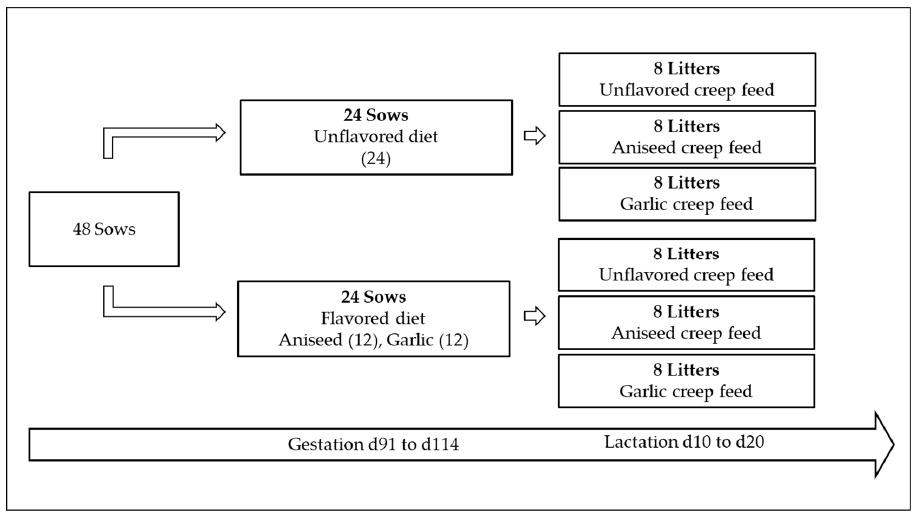
Figure 1. Experimental design considering flavors included in late-gestation maternal diet (days 90